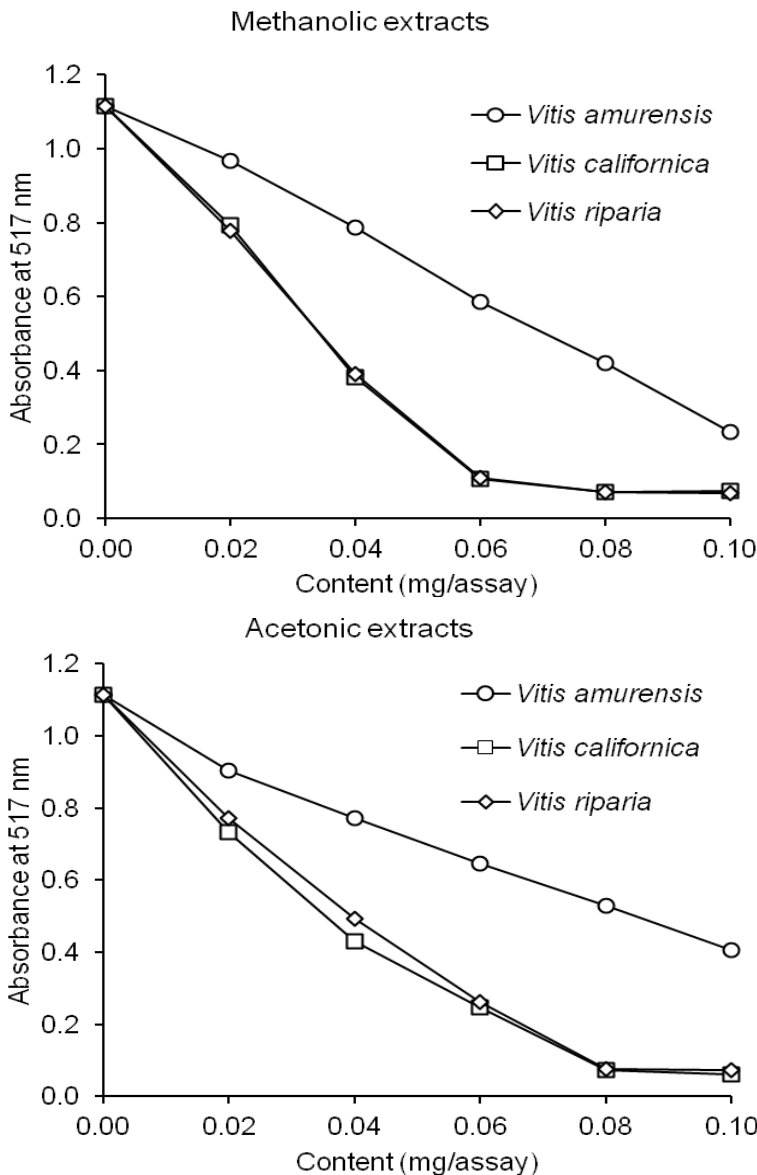
Figure 2. Antiradical activity of methanolic and acetonic extracts of grapevine